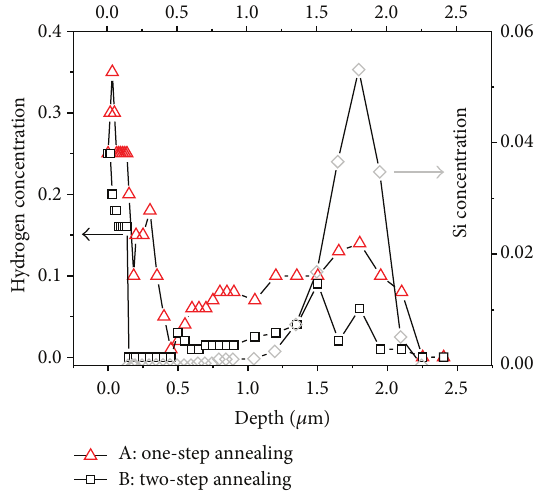
Figure 3: Hydrogen depth profile measured by ERD. Open triangles and squares correspond to the hydrogen concentration for the samples A and B, respectively. The silicon implanted concentration (gray rhombs) calculated by SRIM is shown for